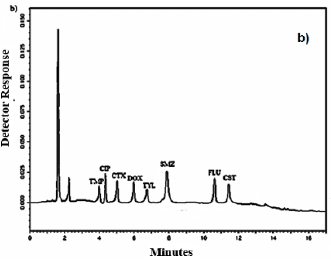
Figure 4. ( a ) Blank chicken sample HPLC-UV chromatogram and ( b ) chromatogram of a blank